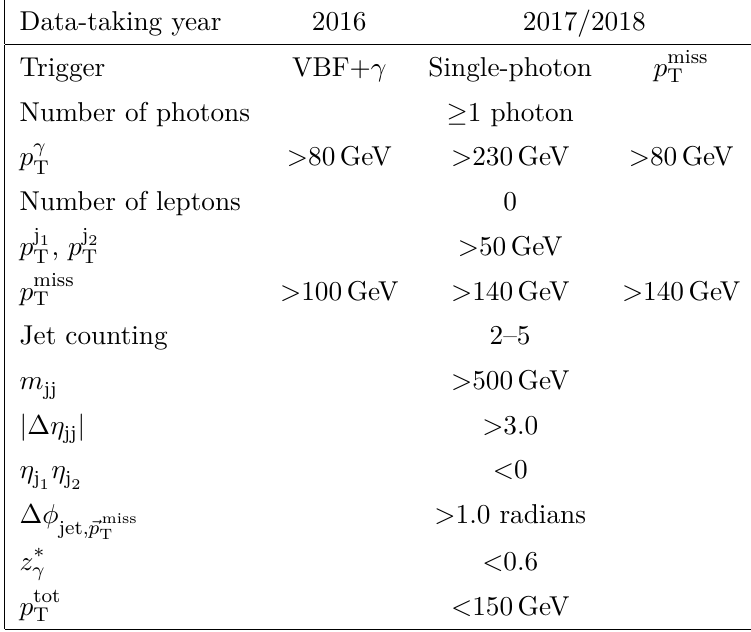
Table 1 . Summary of the selection criteria in the SR, depending on the trigger path and data-taking year. Rows with a single entry indicate that the same requirement is applied for all data-taking years and trigger